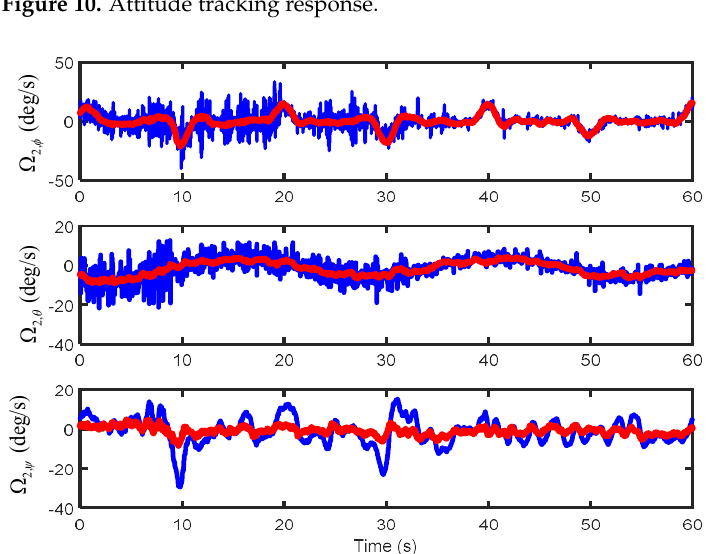
Figure 10. Attitude tracking response.